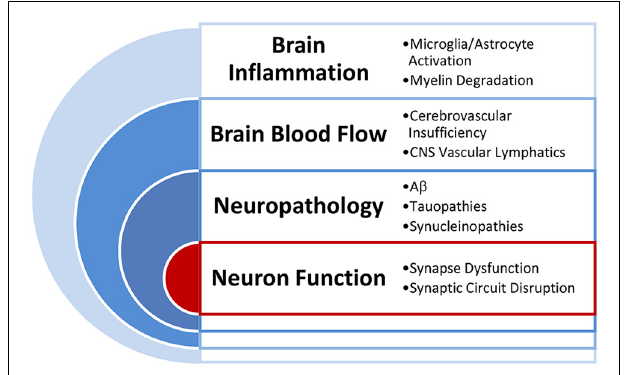
FIGURE 2 | Primary drivers of brain function. Illustration of the interactions of the primary drivers of brain function that work to influence brain health and cognitive outcomes in